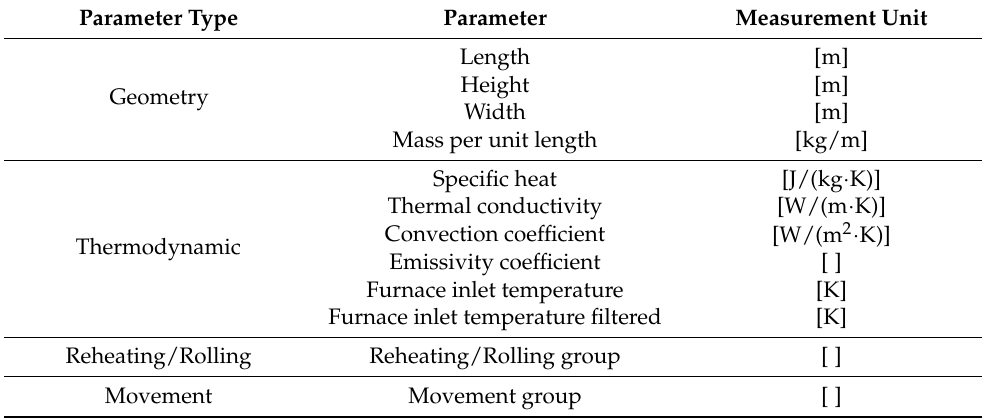
Table 3. Example of billets information.